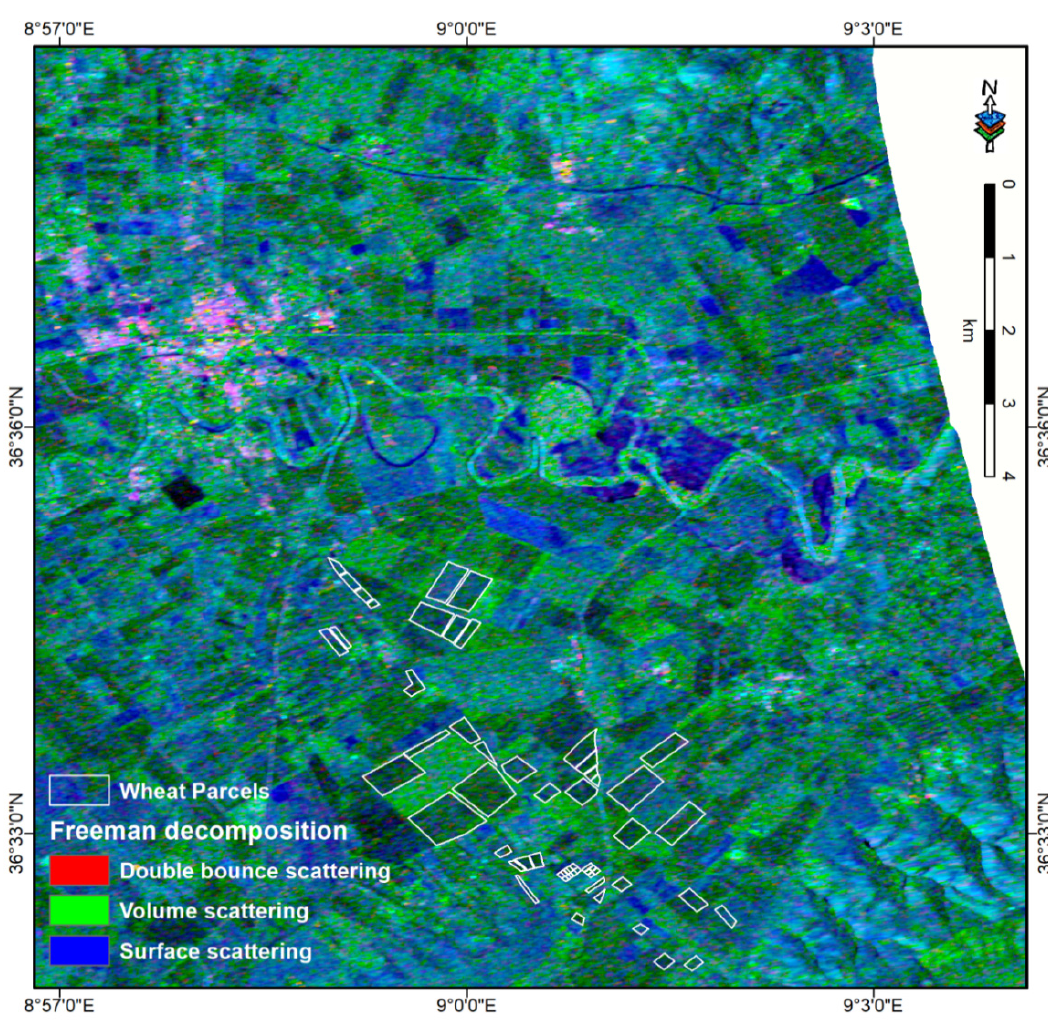
Figure 2. Polarimetric decomposition of Freeman–Druden over the study site (Boussalem); back- ground image RGB = (Freeman_Dbl, Freeman_vol, Freeman_surf) derived from the SAR image acquired on 14 April 2015.